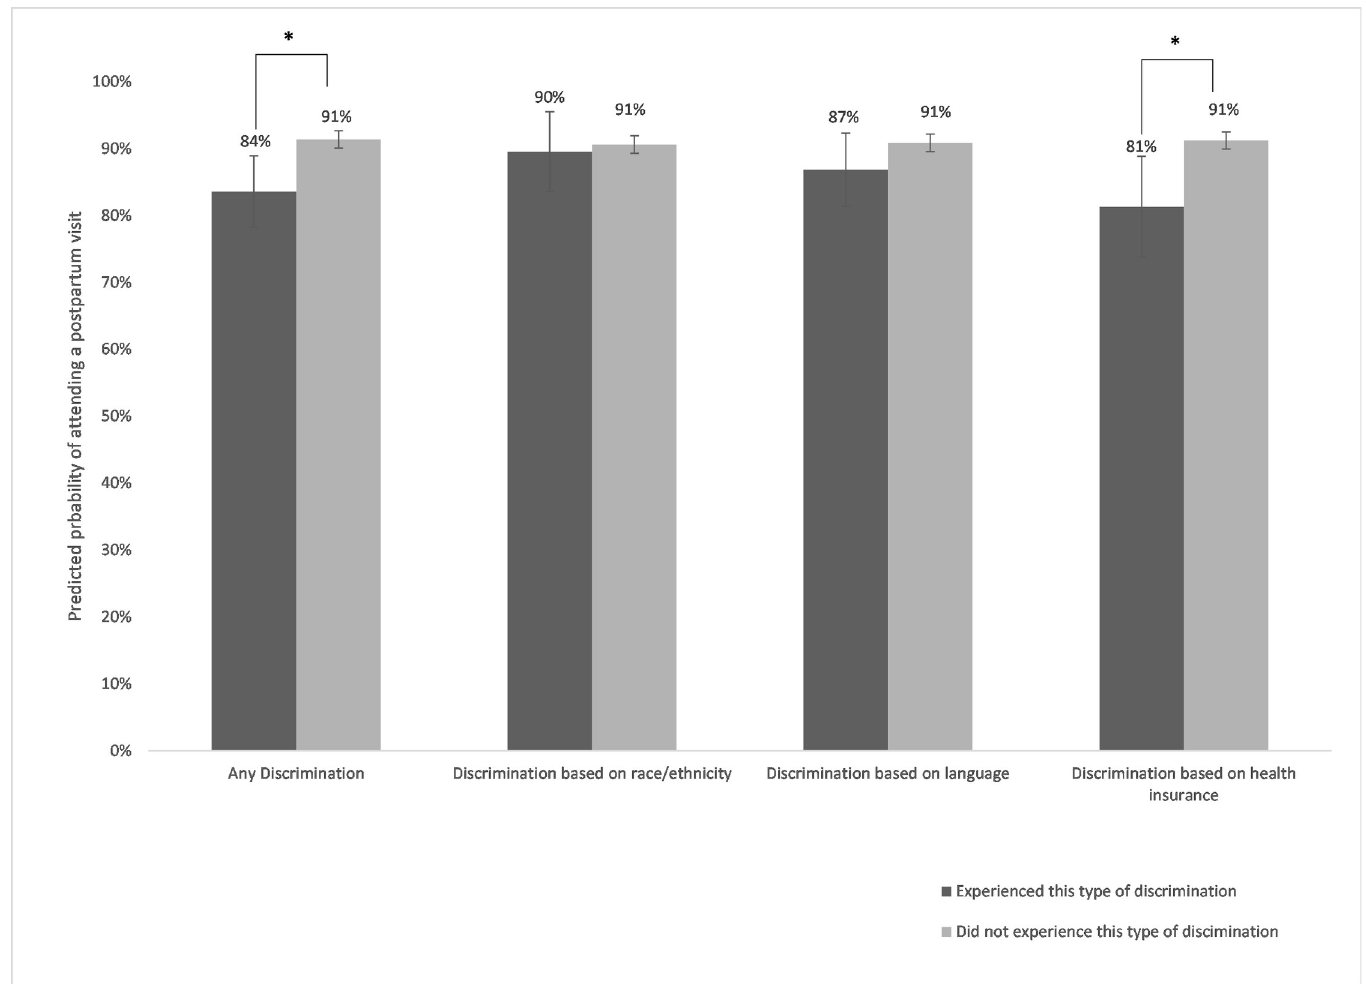
Fig 1. Predicted probability of postpartum visit by perceived discrimination. Note : � Indicates difference between the estimates is statistically significant with p < 0.05. 95% confidence intervals are shown with vertical bars. Predicted probabilities are estimated from logistic regression models adjusted for race/ethnicity, insurance type, education, language, age, birth mode, gestational age, parity, prenatal care provider type, and pre-pregnancy obesity. Results are weighted to be representative of singleton hospital births in California. https://doi.org/10.1371/journal.pone.0253055.g001 Table 3. Perceived discrimination during the childbirth hospitalization and topics addressed at the postpartum visit (N = 2,087). Experienced Experienced discrimination